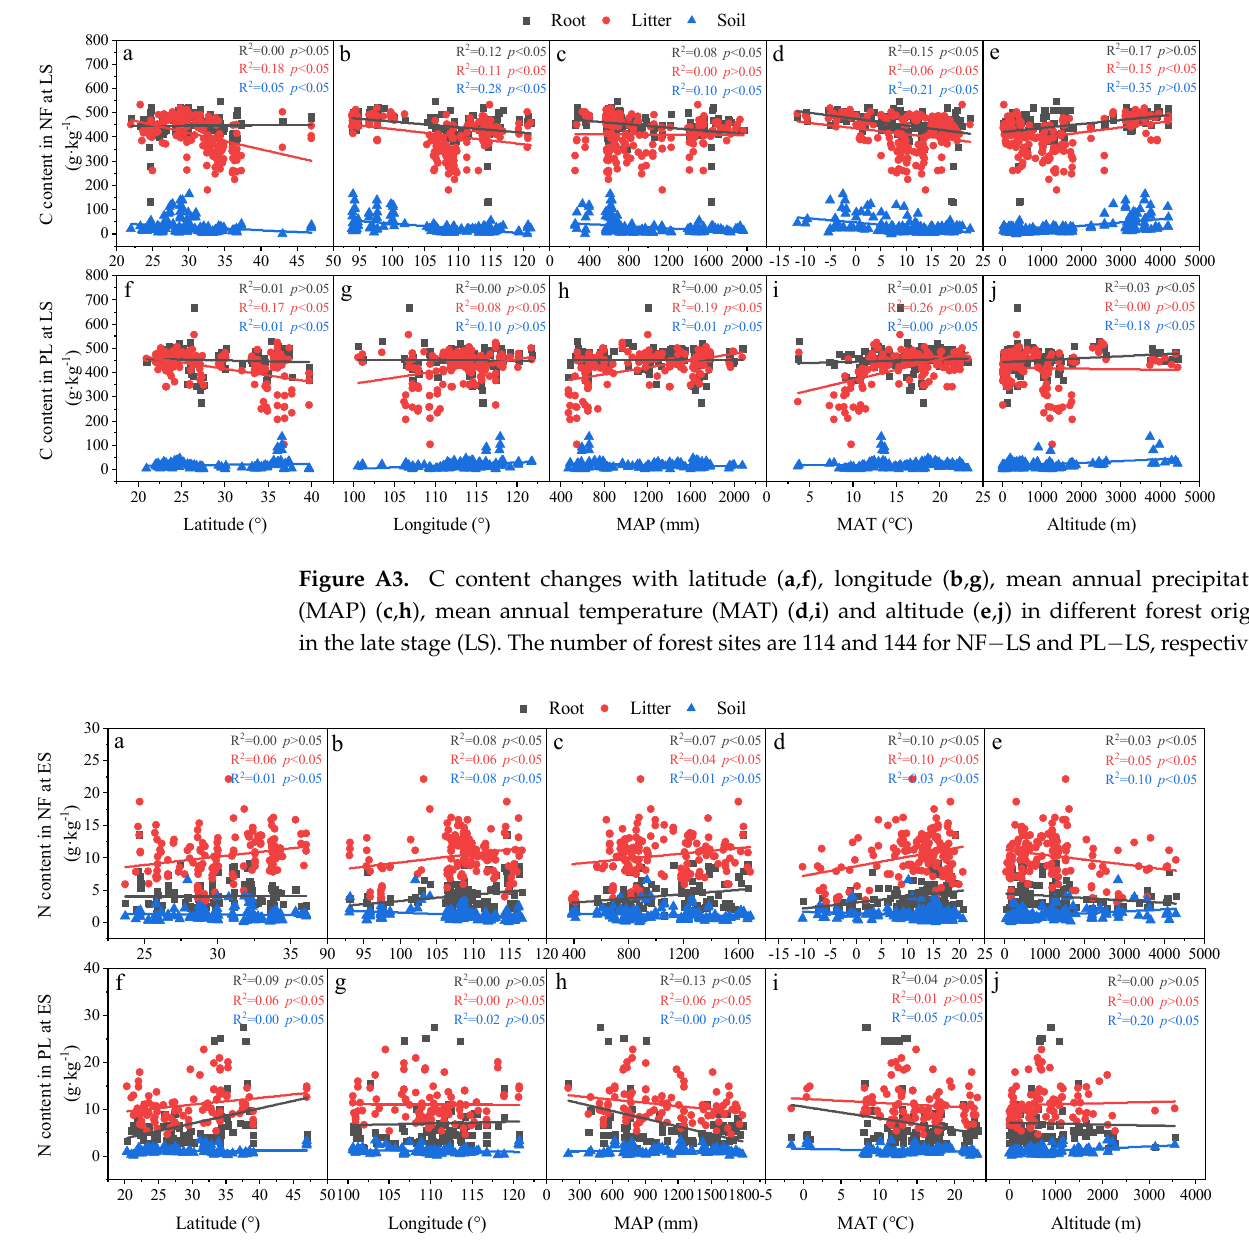
Figure A2. C content changes with latitude ( a , f ), longitude ( b , g ), mean annual precipitation (MAP) ( c , h ), mean annual temperature (MAT) ( d , i ) and altitude ( e , j ) in different forest origins in the middle stage (MS). The number of forest sites are 344 and 199 for NF − MS and PL − MS, respectively.